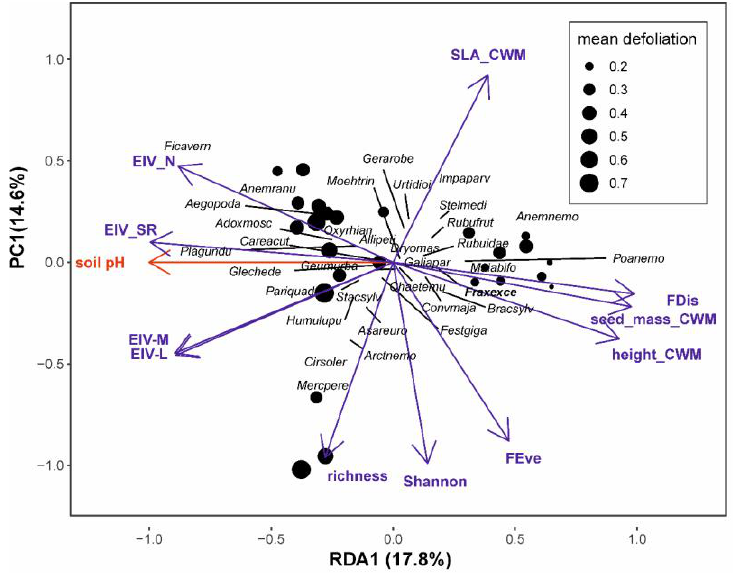
Figure 3. Results of redundancy analysis (RDA) of understory species composition at the background of mean defoliation within the study plots. Each point represent a study plot ( n = 27), black names represent species scores (first four letters of genera and species name; for clarity, only species with total cover > 20% were plotted; all plant species names are given in the Material and methods section). The red label indicates the constraining factor, soil pH (driver of species composition; goodness of fit test in Table 5), while blue labels indicate passively fitted vegetation features (i.e., correlated with species composition gradients; Table 6 for abbreviation and goodness of